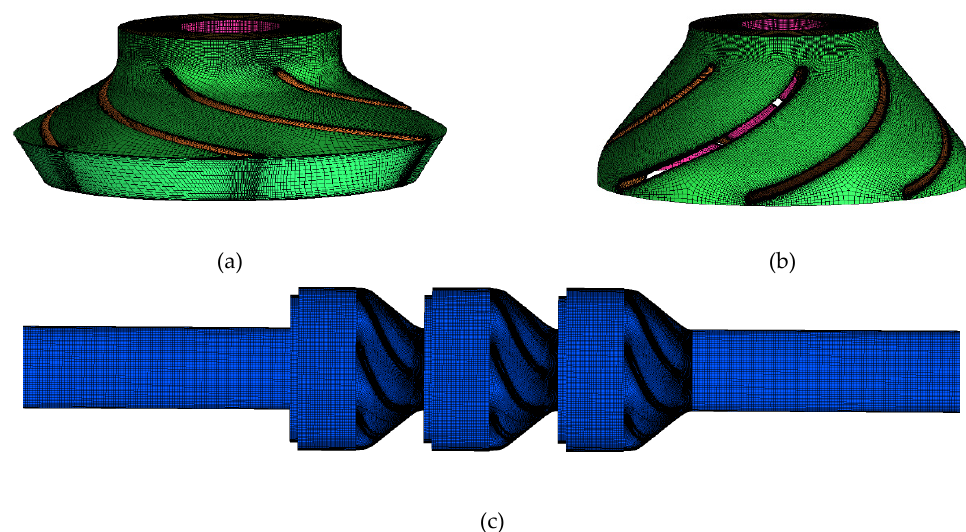
Figure 4. Mesh of impeller and diffuser. ( a ) Impeller, ( b ) diffuser, ( c ) whole calculation domain.